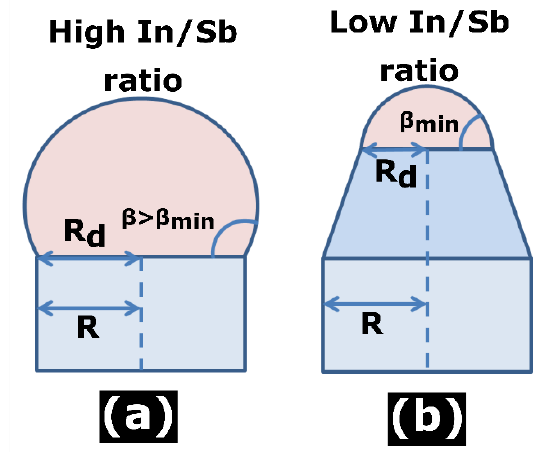
Figure 5. Illustration of ( a ) vertical (for β > β min ) or ( b ) tapered (at β = β min ) NW geometry, with β min ≅ 79° as the small stable angle determined by the surface energetics.